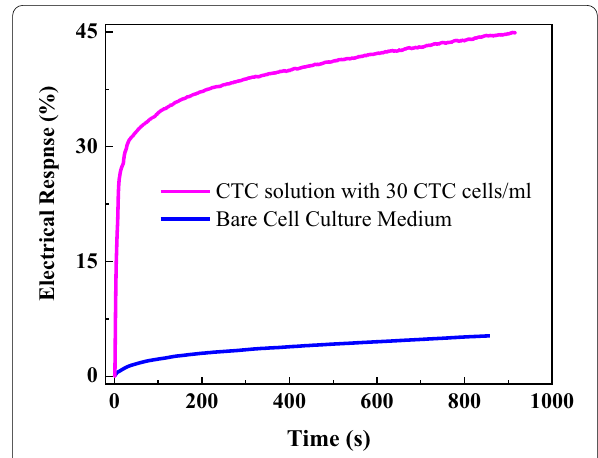
Fig. 4 Time dependence of electrical response for cell culture medium and CTC solution